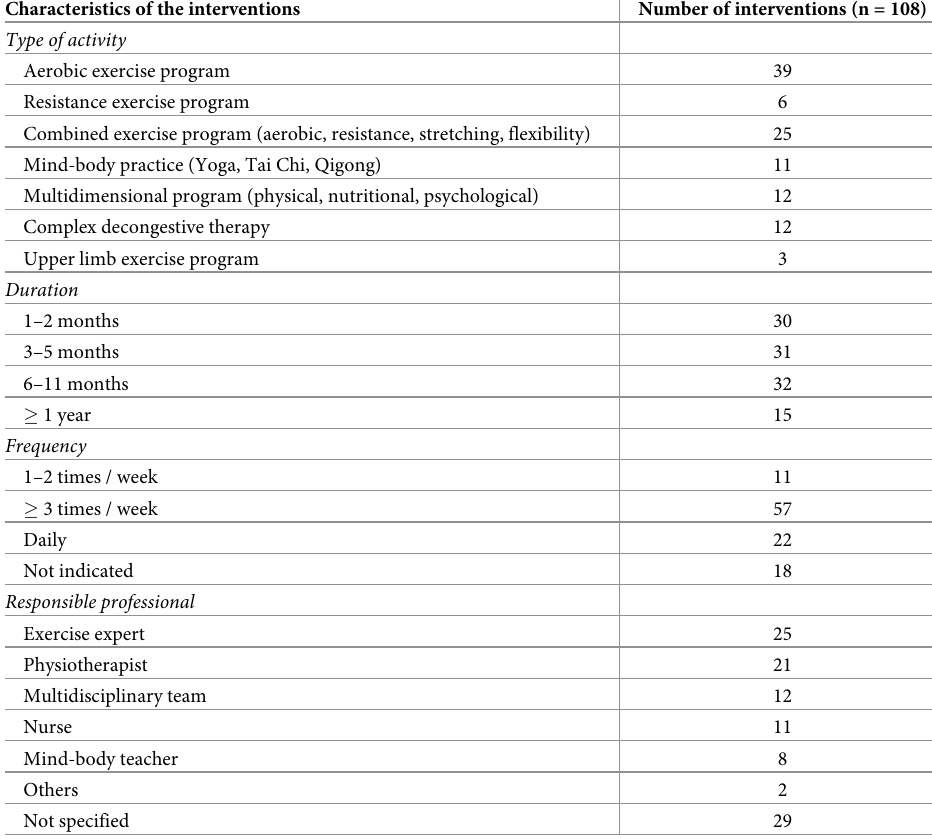
Table 2. Intervention delivered or activity performed by the control group in the studies included in this review. Type of control group Number of studies Two-arm studies (n = 77) Active control group 12 Similar activity with supervision 5 Diet 3 Educational/psychological control group 2 Usual care 55 Three/four-arm studies (n = 5) Active control group and usual care 3 Educational/psychological control group and usual care 1 Similar activity with supervision and usual care 1 Without control group (n = 26)